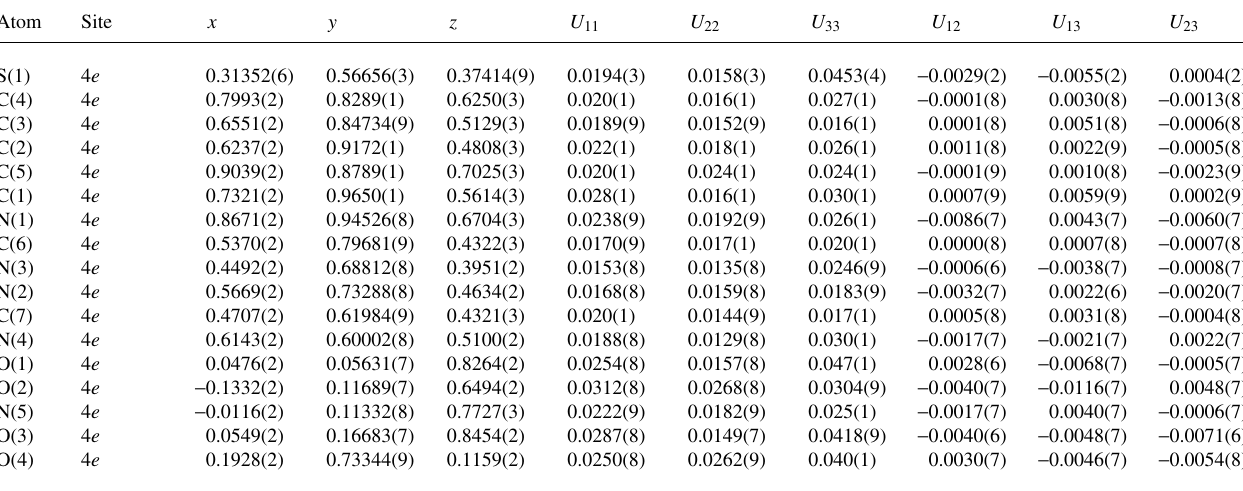
Table 3. Atomic coordinates and displacement parameters (in Å 2 )